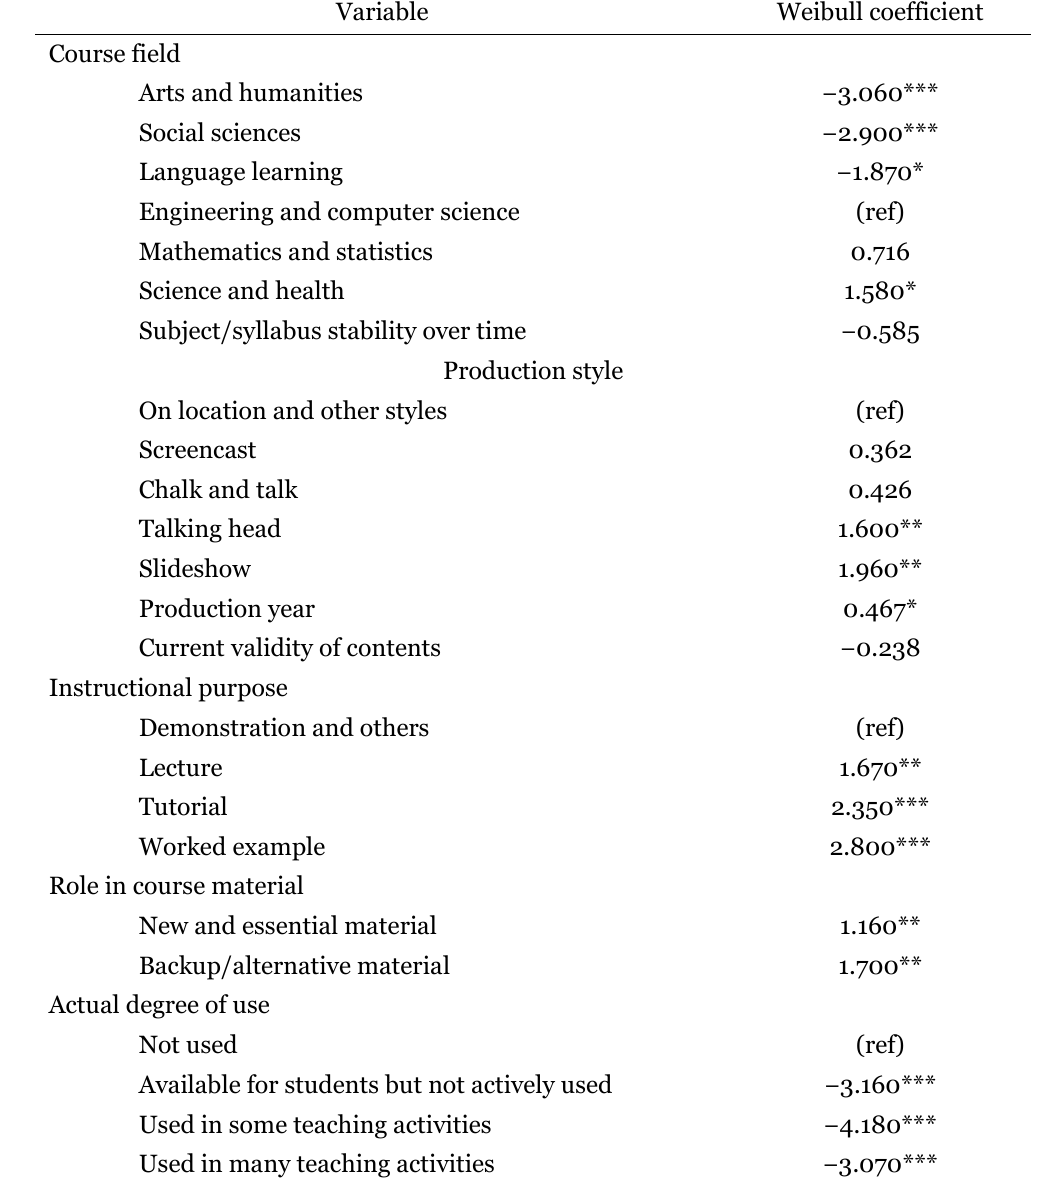
Survival Model: Parameters and Weibull